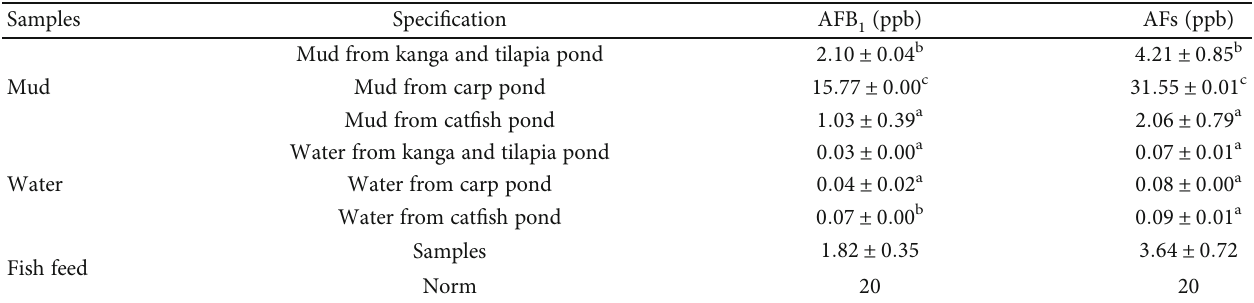
n = 34 . Values are expressed as mean ± standarddeviation . Values bearing the same superscript letter on the same row are not signi fi cantly di ff erent at p < 0 : 05 according to the Duncan multiple range test. Norm=mycotoxin regulatory guidance of the Food and Drug Administration [21]. Table 2: Levels (ppb) of total a fl atoxins and a fl atoxin B